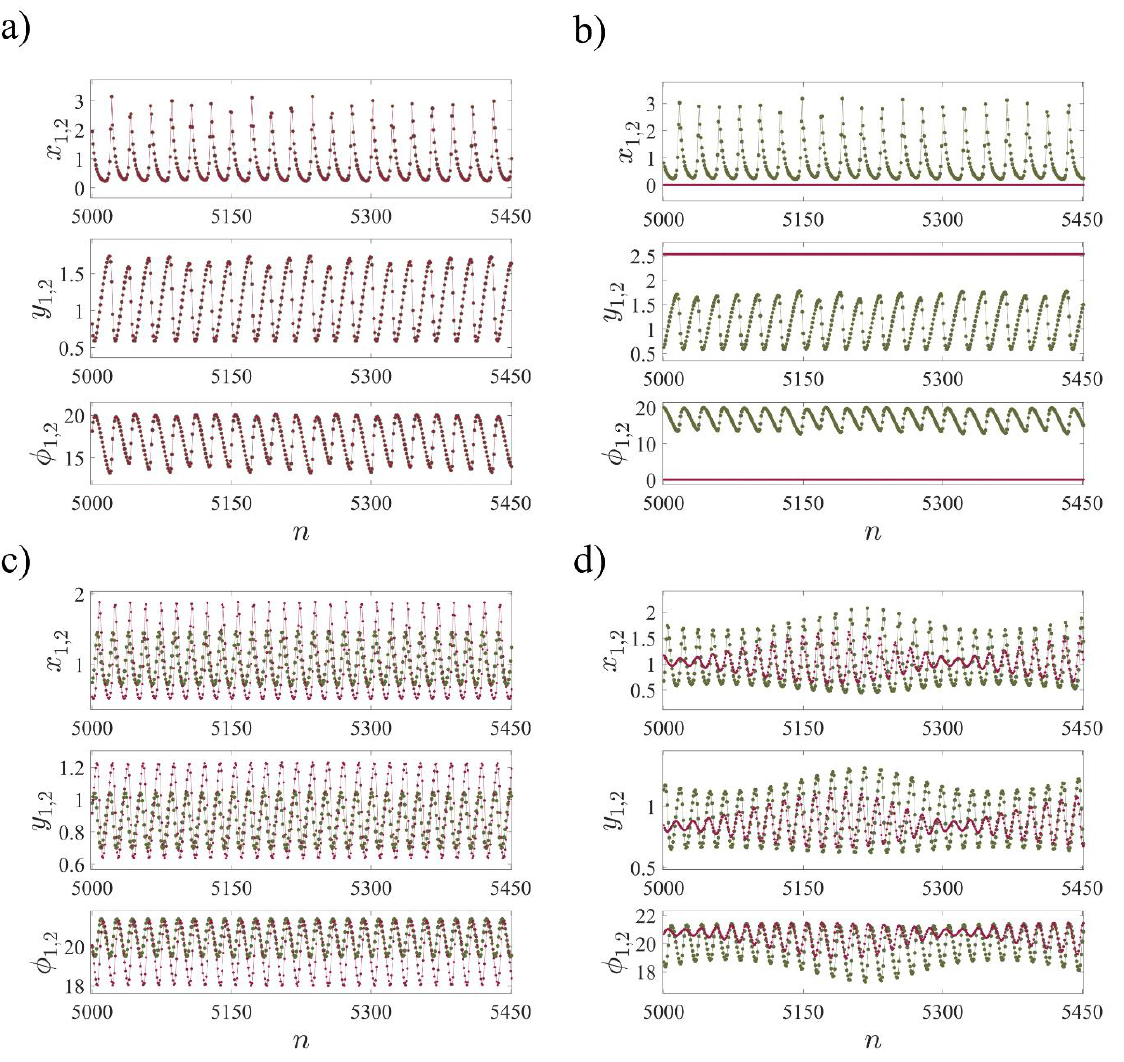
Figure 8. x , y , and φ variables of the network in the time domain for different chem- Figure 8. 𝑥 , 𝑦 , and 𝜙 variables of the network in the time domain for different chemical and elec- ical and electrical couplings when parameters are set, as mentioned in Table 3, with trical couplings when parameters are set, as mentioned in Table 3, with (𝑥 1 (0), 𝑦 1 (0), 𝜙 1 (0)) = ( 0 ) , y ( 0 ) , φ ( 0 )) = ( 1.0, 0.8, 0.2 ) and ( x ( 0 ) , y ( 0 ) , φ ( 0 )) = ( 0.5, 0.2, 0.3 ) as initial con- ( x 2 2 2 1 1 1 (1.0, 0.8, 0.2) and (𝑥 (0), 𝑦 (0), 𝜙 (0)) = (0.5, 0.2, 0.3) as initial conditions. ( a ) 𝑔 = 0.0 and 2 2 2 𝑐ℎ ditions. ( a ) g ch = 0.0 and g el = 0.07; ( b ) g ch = 0.0002 and g el = 0.0; ( c ) g ch = 0.0002 and 𝑔 = 0.07 ; ( b ) 𝑔 = 0.0002 and 𝑔 = 0.0 ; ( c ) 𝑔 = 0.0002 and 𝑔 = 0.025 ; and ( d ) 𝑔 = 𝑒𝑙 𝑐ℎ 𝑒𝑙 𝑐ℎ 𝑒𝑙 𝑐ℎ g el = 0.025; and ( d ) g ch = 0.0005 and g el = 0.02. In the absence of g ch , synchronization can be 0.0005 and 𝑔 = 0.02 . In the absence of 𝑔 𝑒𝑙 𝑐ℎ , synchronization can be seen; while in the absence of seen; while in the absence of g el , no synchronization occurs. 𝑔 𝑒𝑙 , no synchronization occurs. The network basin of attraction is also plotted for coupled 3D-MCMs. Figure 9 shows the oscillators’ dynamics with initial conditions ( x 1 ( 0 ) , 0.8 , 0.2 ) and ( x 2 ( 0 ) , 0.2 , 0.3 ) . The initial conditions in the purple region are x 1 ( 0 ) and x 2 ( 0 ) , which leads the networks to oscillate chaotically but not necessarily synchronously. The ones in the blue region lead to the quiescent state. The system parameters are set as mentioned in Table